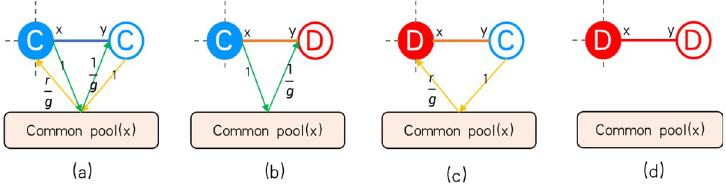
Fig 2. Four cases of the center node x and the neighbor node y . In four cases, the amount that the central node x receives from neighbor y and the cost to neighbor y are analyzed. The green arrow shows the amount that the center node gives to the neighbor node, and the yellow arrow shows what the center node gets from the neighbor node. A red node indicates that the node is a defector, and blue indicates that the node is a cooperator. g is the number of players in the game centered on x